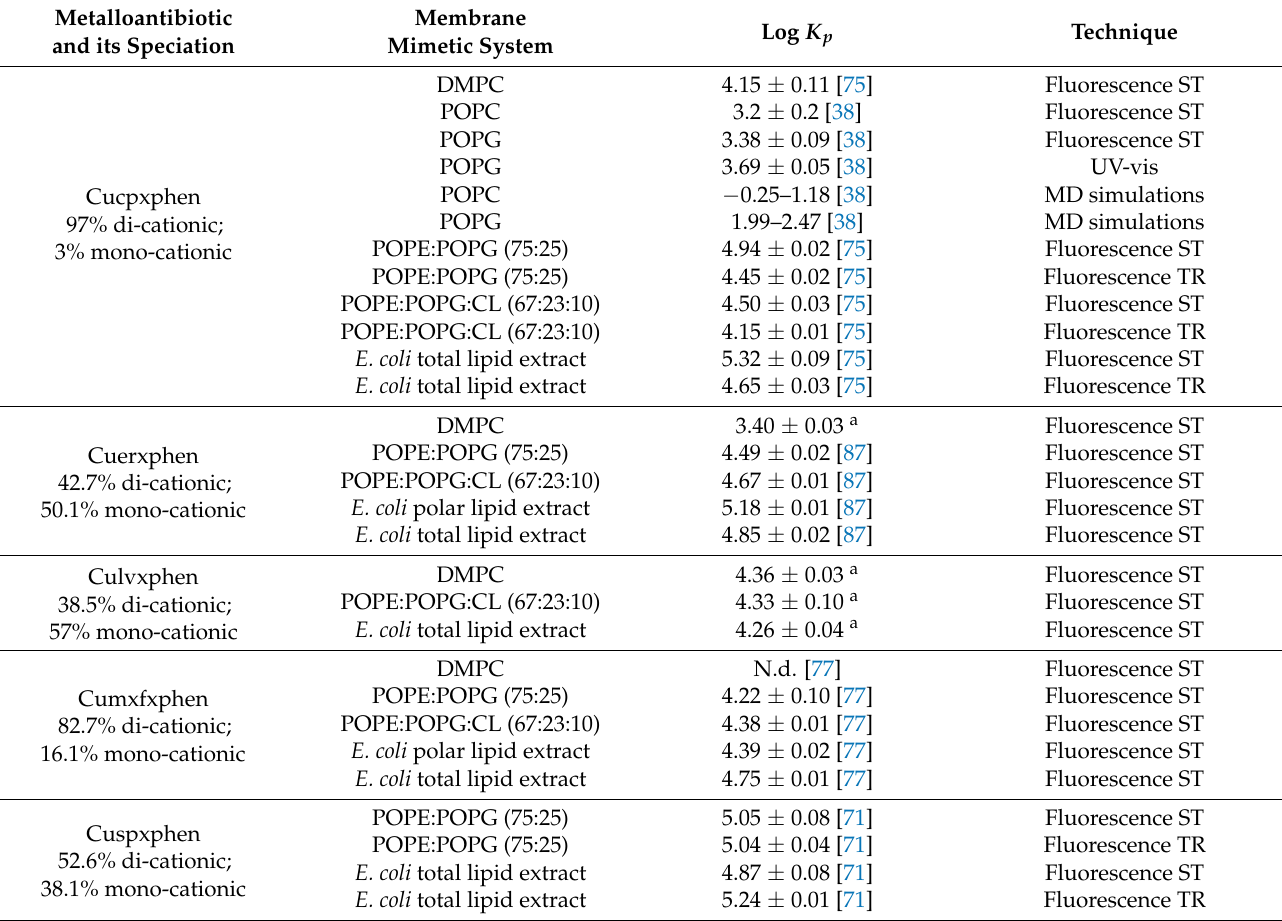
Table 2. Values for the partition constants ( K p ± SD) of metalloantibiotics in different membrane mimetic systems of prokaryotic and eukaryotic cells, obtained by fluorescence and UV-vis spectroscopies and molecular dynamics (MD) simulations, from [38,71,75,77,87]. Speciation under physiological conditions (pH 7.4; concentrations in the same range of those used in the partition